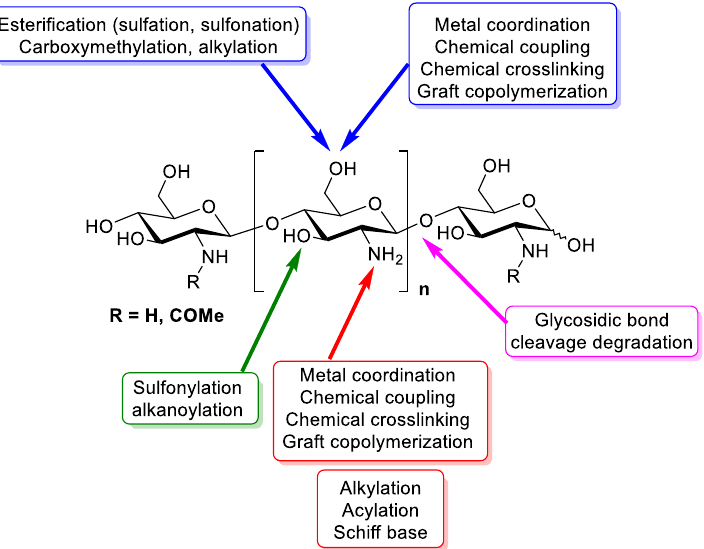
Figure 1. Functional groups in chitosan’s structure that are able to be chemically modified.